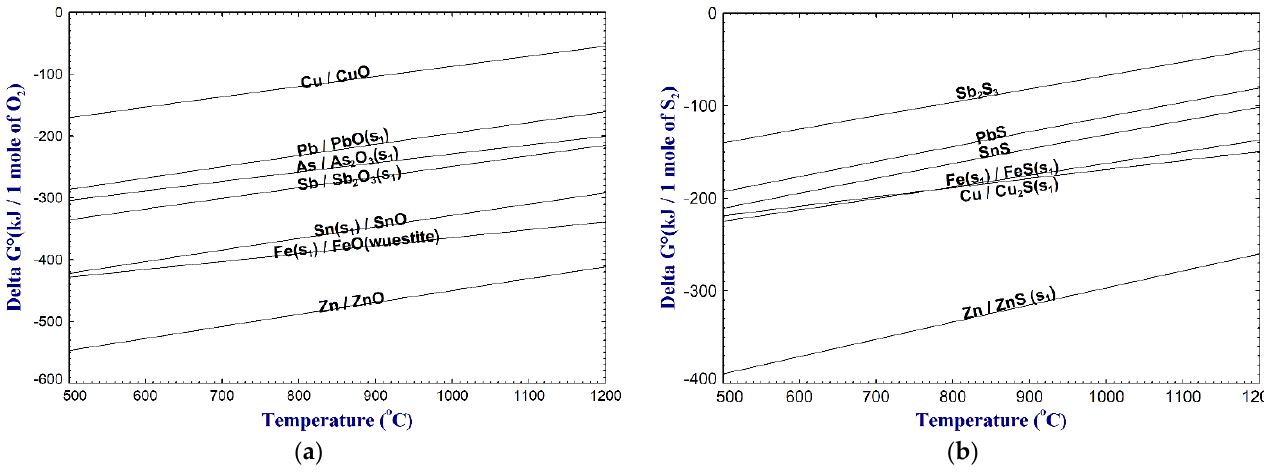
Figure 15. Gibbs energies of formation of different ( a ) oxides and ( b ) sulfides from their pure elements and 1 mole of oxygen (calculated using FactSage 8.1 FactPS database) [83].